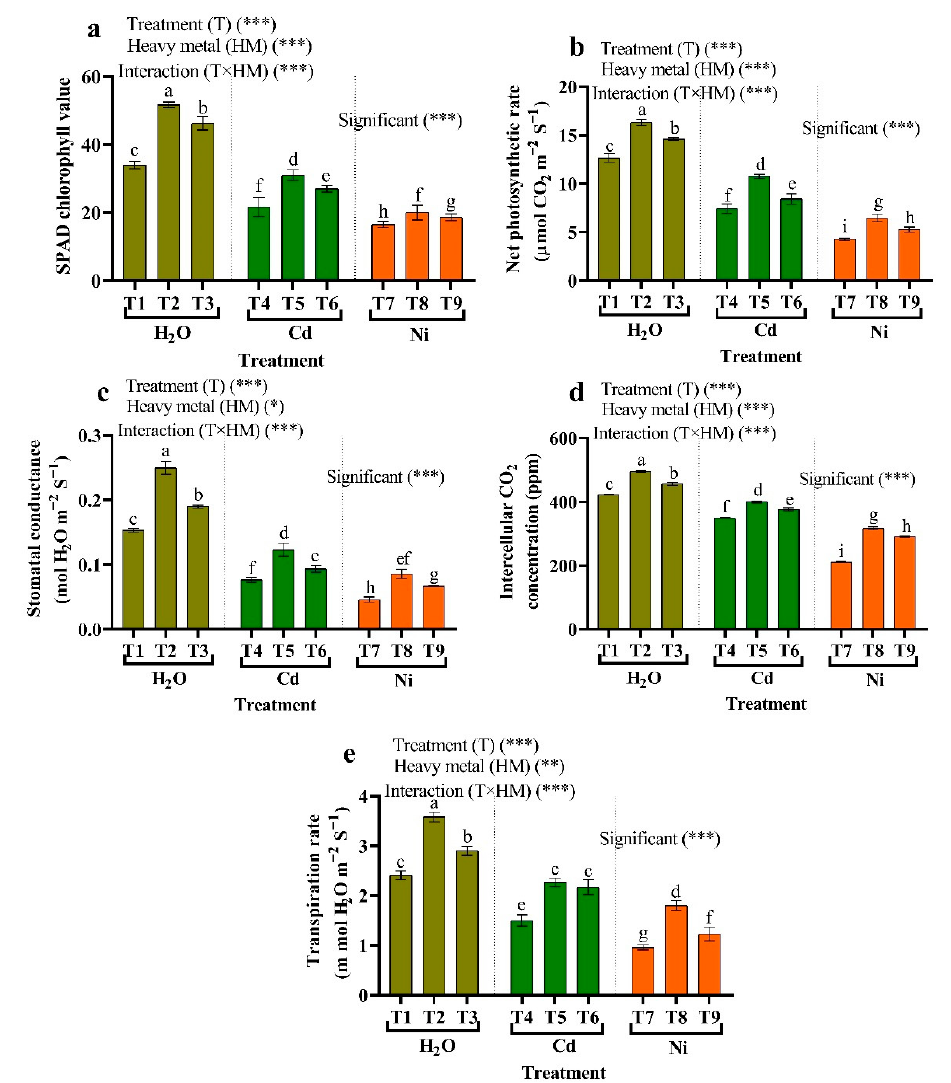
Figure 4. The influence of two different endophytic bacteria on ( a ) SPAD chlorophyll values, ( b ) net photosynthetic rate (PN), ( c ) stomatal conductance (gs), ( d ) intercellular CO 2 concentration (Ci), and ( e ) transpiration rate (E) in tomato plants growing under HM stress. Fisher’s test at p < 0.05 reveals significant variations in means ( ± standard error), which are different letters (a–i) on the same bars. Thus, *, ** and *** imply significance levels of 0.01 and 0.05, respectively. T1: (Control with tap